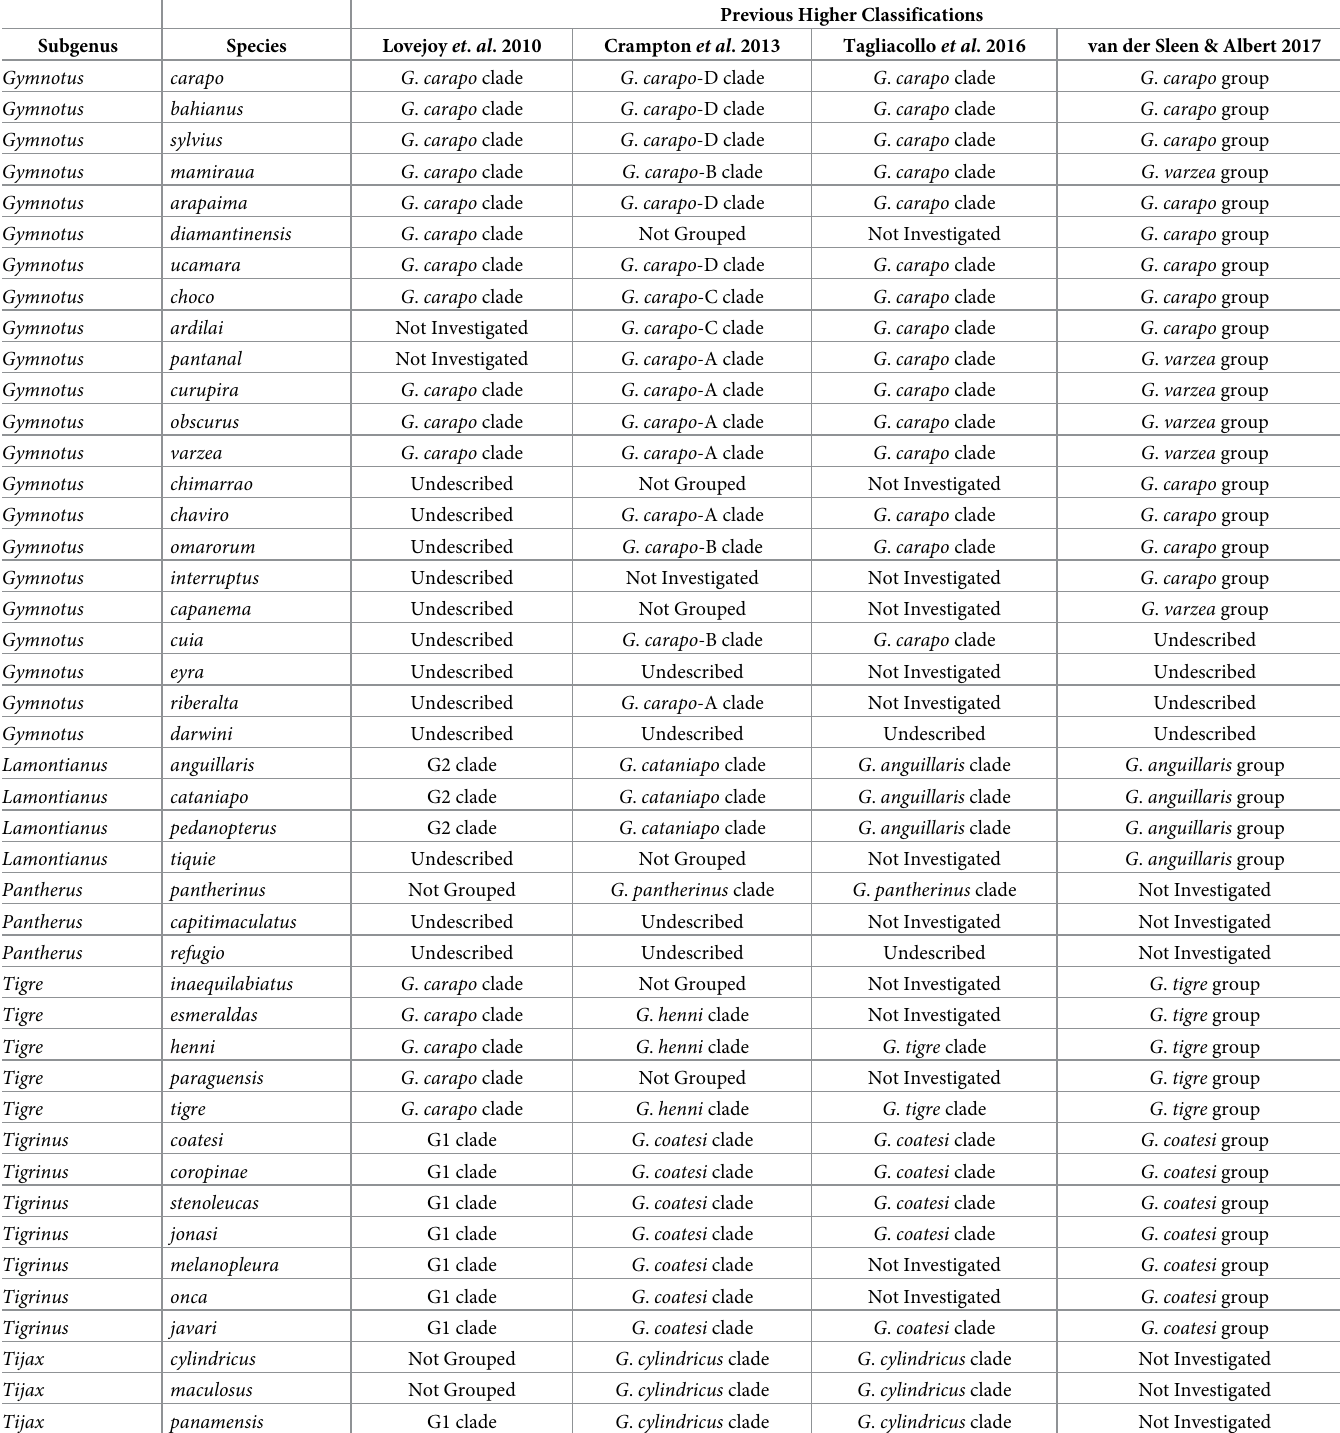
Table 4. List of valid gymnotine species and higher taxa to which each was assigned in three taxonomic revisions from 2010–2017. Species are marked "undescribed" if they had not been described at the time of the study, "not investigated" if they fell outside the scope of that study, and "not grouped" if they were not assigned to a higher